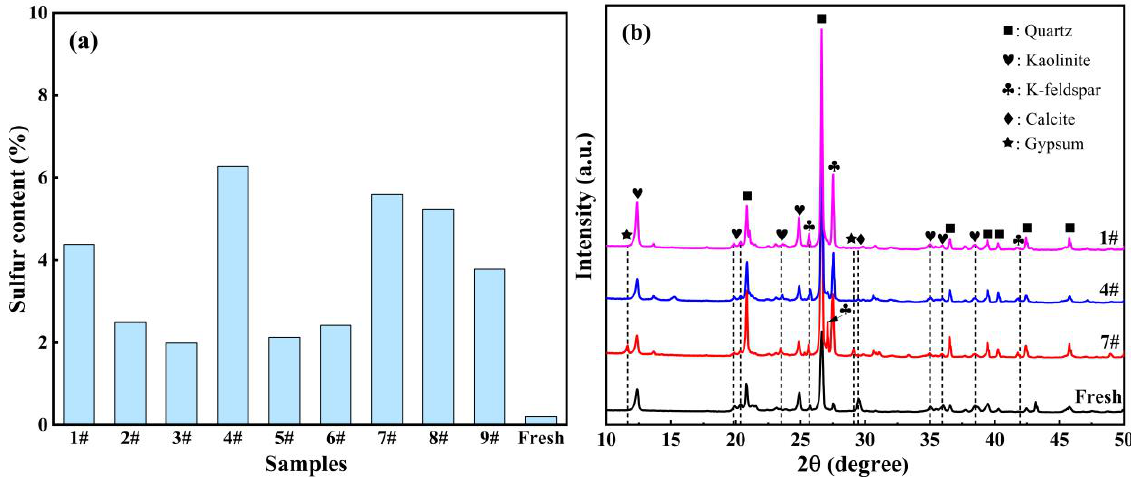
Figure 4. Chemical analysis of sandstone samples in the Yungang Grottoes: ( a ) sulfur content and ( b ) mineralogical composition.